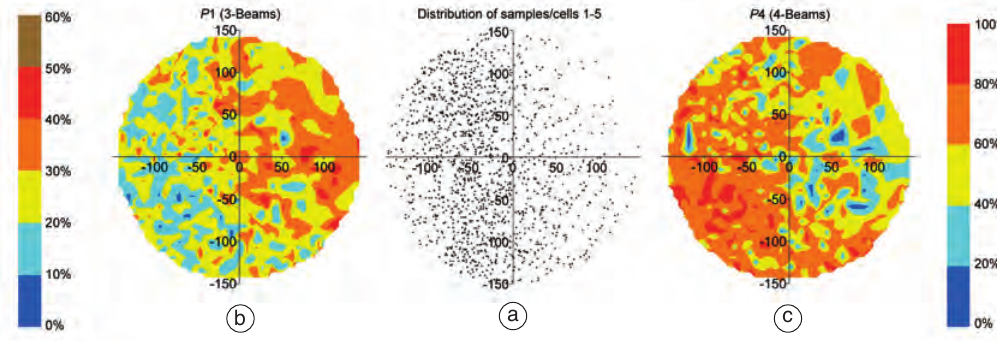
Fig. 9a-c. a) Distribution of samples for cells #1-5 as a function of the current direction and speed up to 150 mm/s (north is upward). b) Distribution of the percentage of data computed from 3 beams only ( P 1) and corre- sponding scale. c) Distribution of the percentage of data computed from 4 beams ( P 4) and corresponding scale.